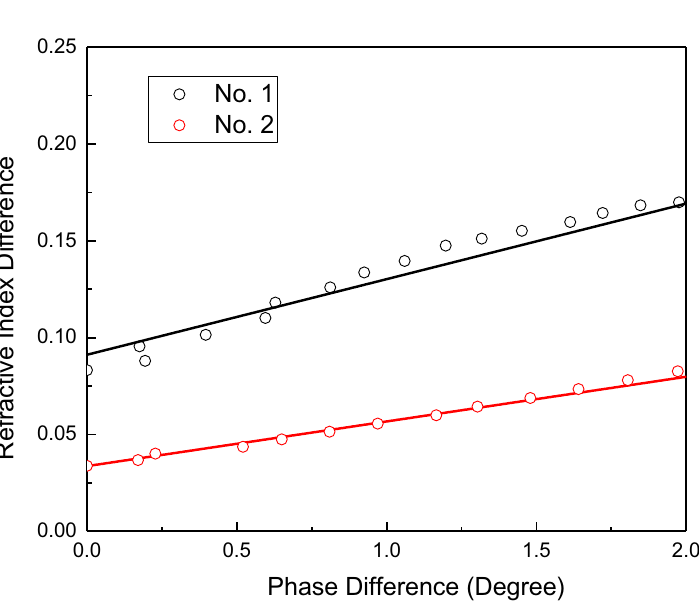
Figure 7. The refractive index difference versus phase shift curves for corneal sample No. 1 and No. 2 at stress duration of 10